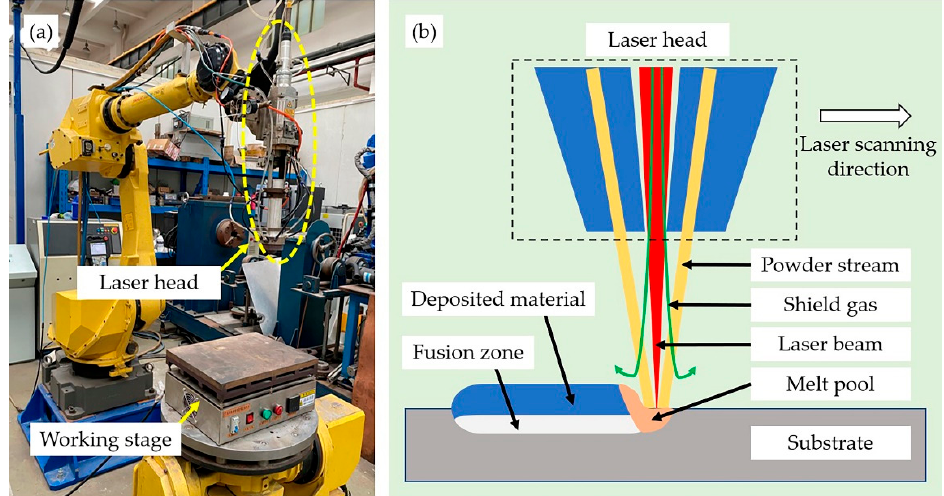
Figure 2. IPG YLS-10000 laser equipment: ( a ) overview of the equipment; ( b ) schematic diagram of the laser cladding process.